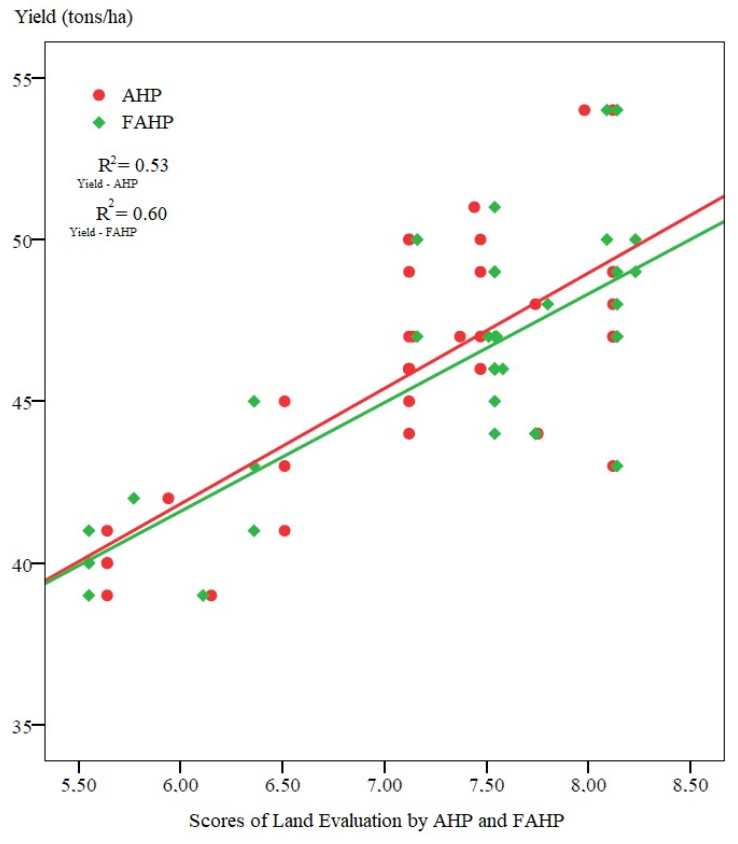
Figure 6. Comparison of coefficient of determination of both methods.